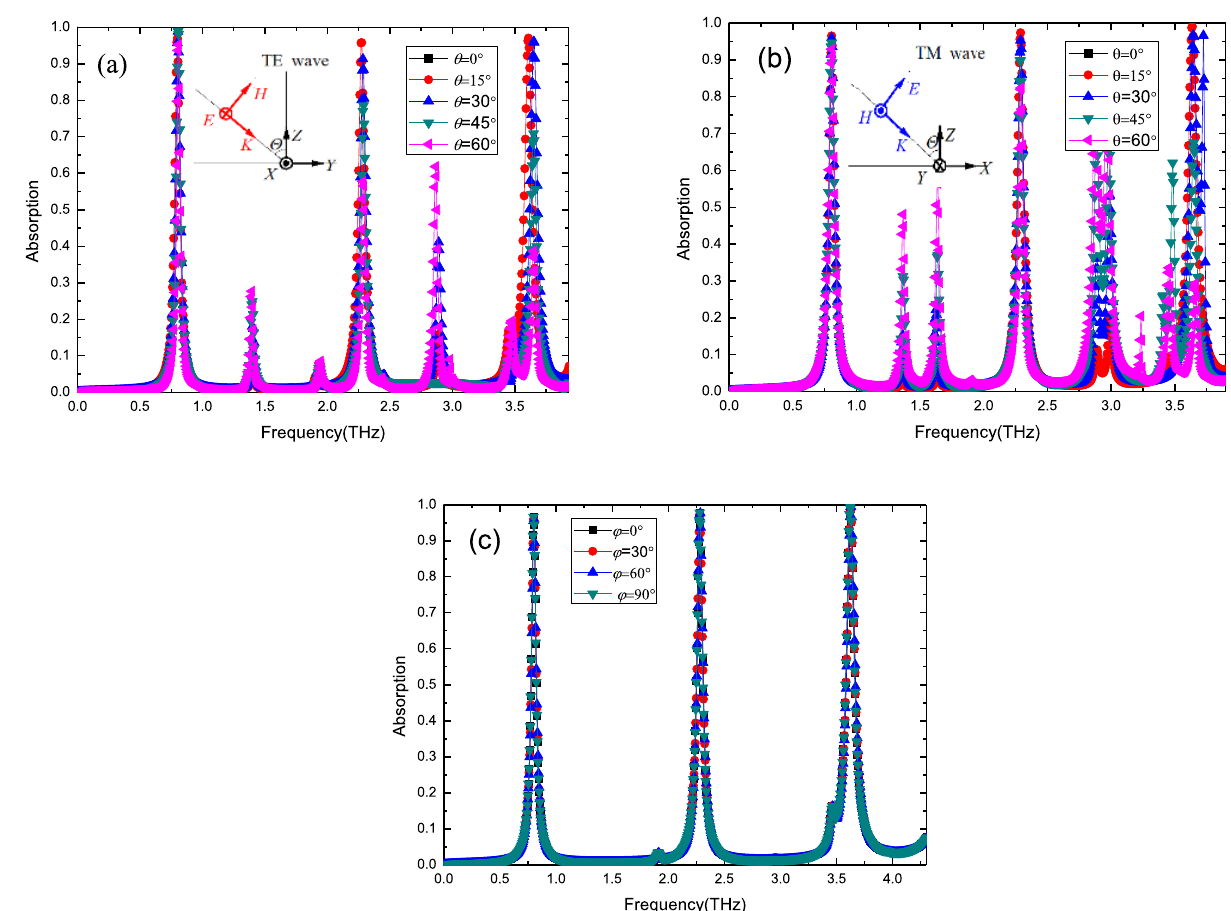
Fig. 6. Absorption spectra at different incident angles for (a) TE and (b) TM waves, when the azimuthal angle is fi xed to ’ = 0 (cid:4) . (c) Absorption spectra at different polarization angles when the incident angle is fi xed to u =0 (cid:4)